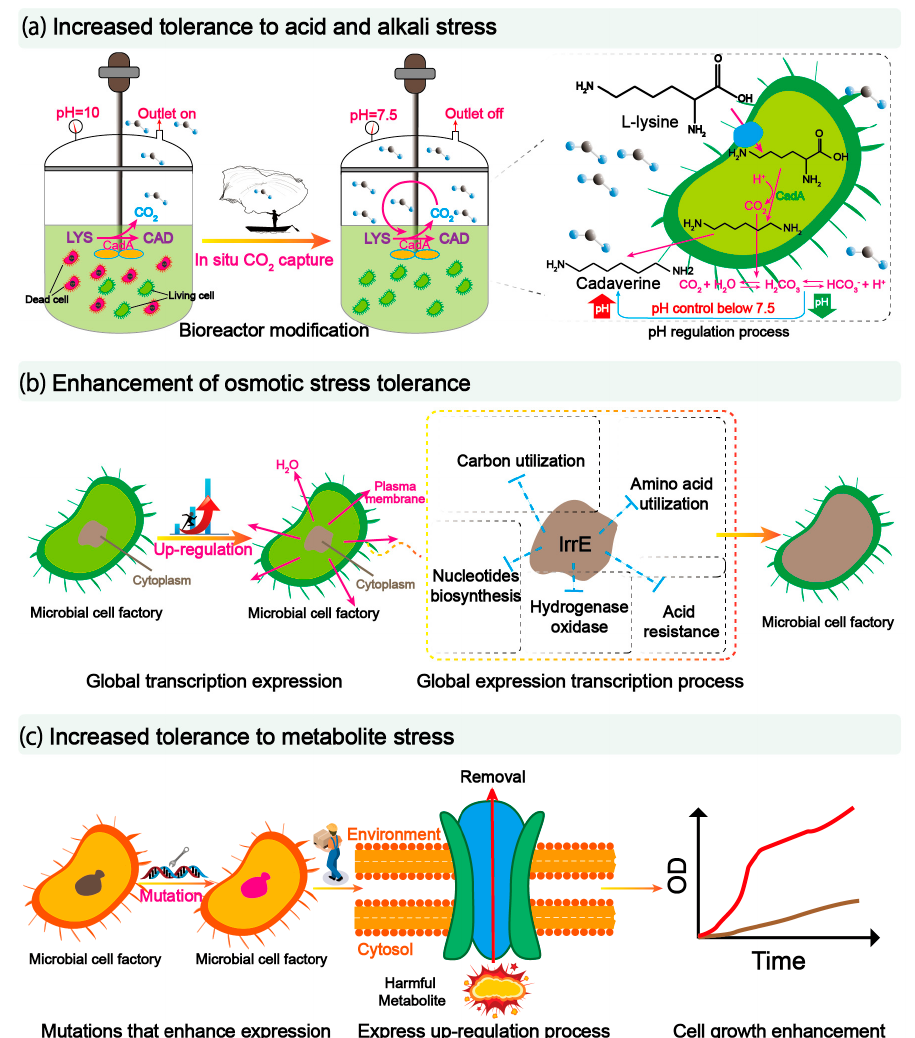
Figure 4. Strategies for enhancing chassis cell environmental adaptation. ( a ) The in situ CO 2 capture strategy was used to dissolve free CO 2 to reduce the pH value of the conversion synthesis system of cadaverine, thus strengthening the acid-base tolerance stress of chassis cells. LYS, L-lysine; CadA, L-lysine decarboxylase; CAD, cadaverine. ( b ) Express the global transcription factor IrrE, improve the synthesis of E. coli osmoprotector and osmotic pressure tolerance, enhance cell growth and butyric acid synthesis under hypertonic environment, and achieve the enhancement of osmotic tolerance stress of chassis cells. ( c ) Overexpression of multidrug tolerance transporter QDR3 improved the tolerance of yeast cells to adipic acid and enhanced the tolerance of chassis cells to metabolite stress.